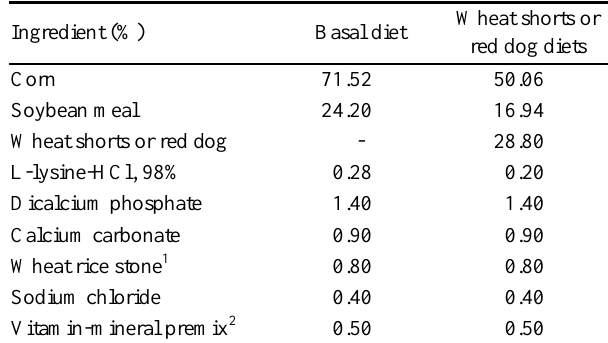
Table 2. Ingredient of composition of experimental diets (Exp. 1, % as fed)